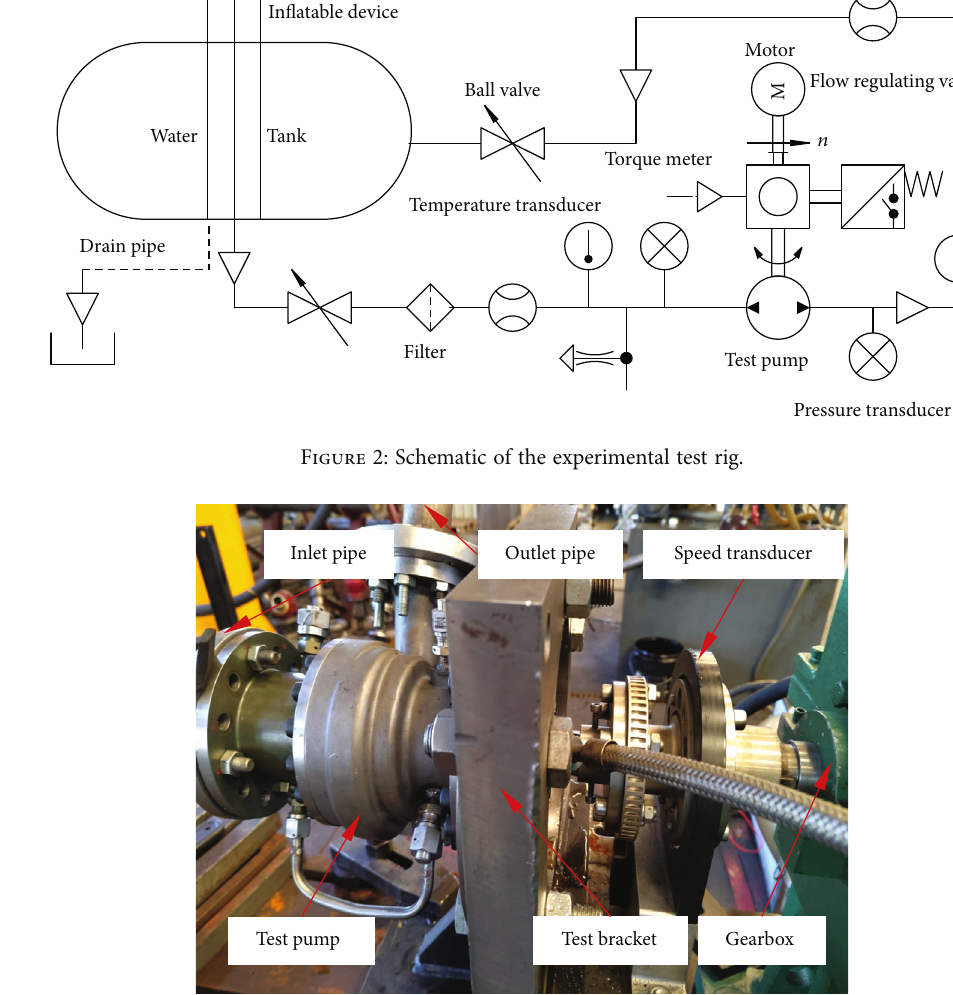
Figure 3: Test facility at Xi ’ an Jiaotong